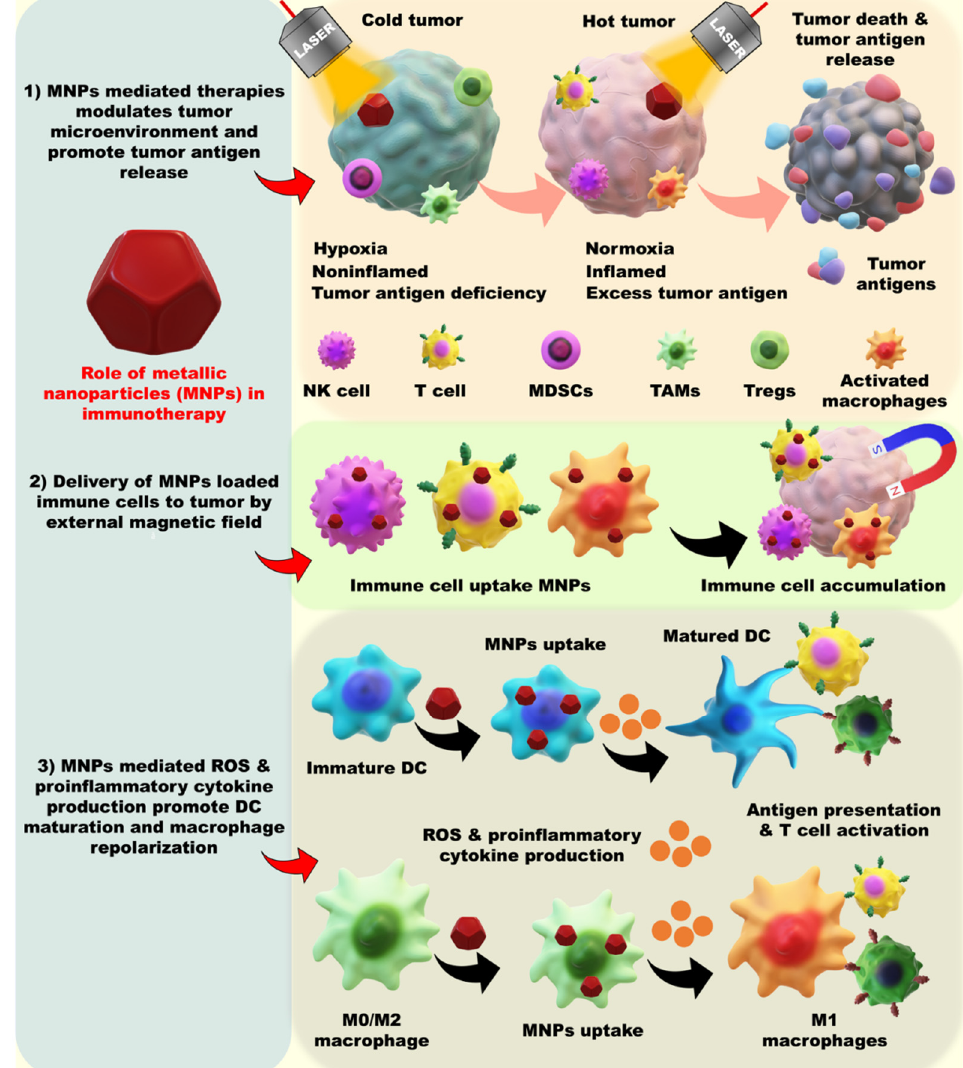
Figure 6. Schematic representation of the role of MNPs in immune cell modulation. (1) MNPs and MNP-mediated therapies modulate the TME conversion from cold to hot tumor type and represent accessible therapeutic strategies. MNP-mediated therapies, such as PTT, PDT, CDT, SDT, MHT, and IT, cause tumor cell death and promote tumor antigen production. (2) MNP-loaded immune cells, such as NK cells, T-cells and macrophages, are externally targeted to promote an immune response against tumors by external magnets. (3) MNPs promote intracellular ROS generation and pro-inflammatory cytokine production, which convert immature DCs to mature DCs and promote antigen presentation. Similarly, ROS and pro-inflammatory cytokine production promote pro-inflammatory macrophages conversion and elevate antigen presentation to cytotoxic T cells. MNPs stimulate in-